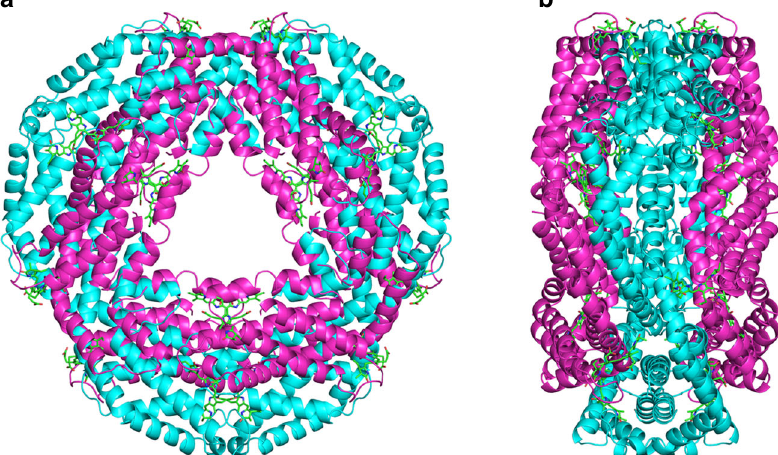
Fig. 4 Overall structure of the biological assembly of phycocyanin: symmetry-related chains A in cyan, chains B in magenta displayed as cartoon. The phycocyanobilin molecules are shown in green. a View along the symmetry axis with b being a 90° rotation displaying the assembly from the